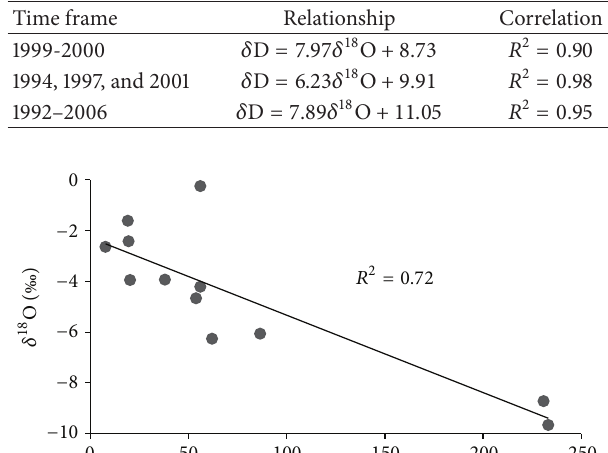
Table 2: Annual weighted mean of rainfall water isotopes from Islamabad.